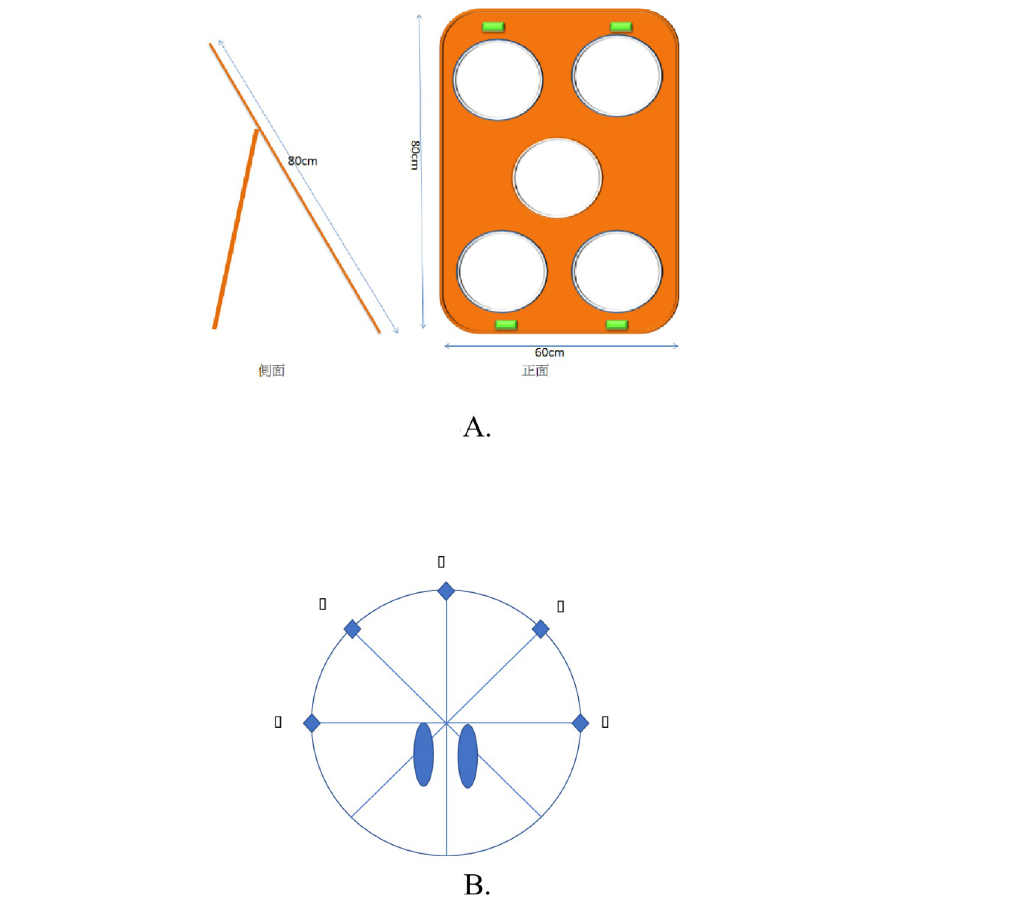
Fig 3. A. The design and outlay of the beanbag toss board. B. A-E indicates the location of the beanbags. There are two beanbags at each location. The two ovels are the location where the feet were placed when the participants performed the